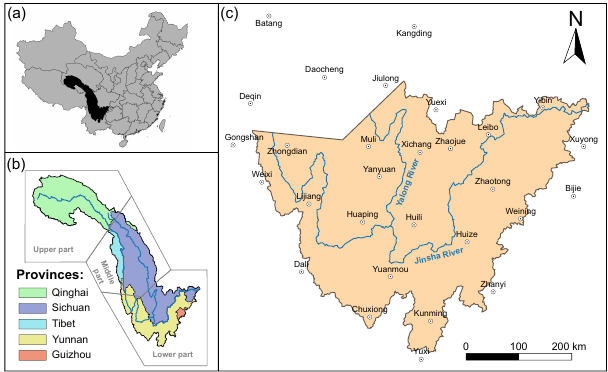
Figure 1. (a) Location of the JRB in China; (b) subdivision of the JRB for this study; (c) overview of the lower JRB with the location of the 29 meteorological